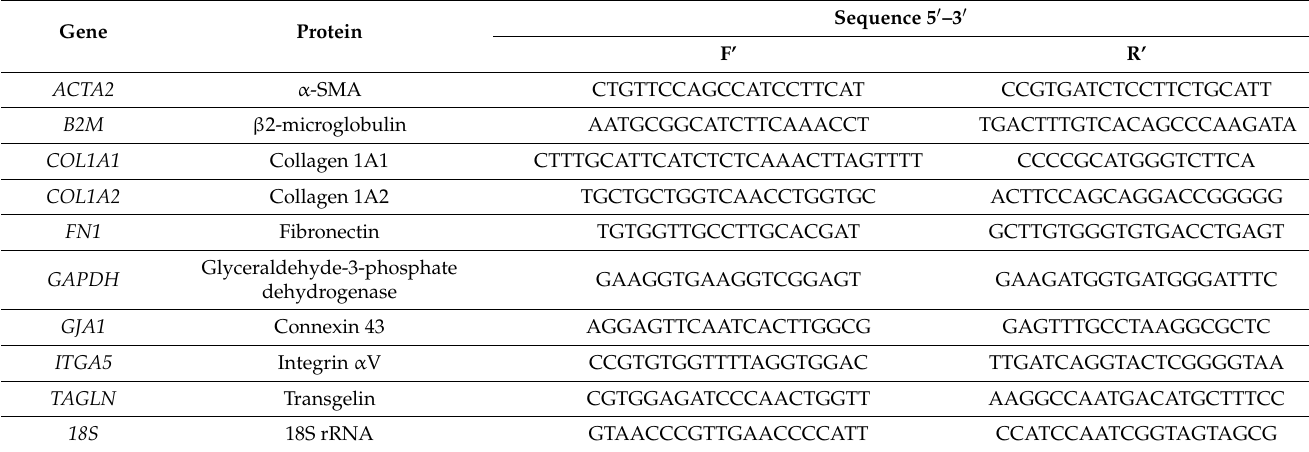
Table 1. Primer sets used for real-time